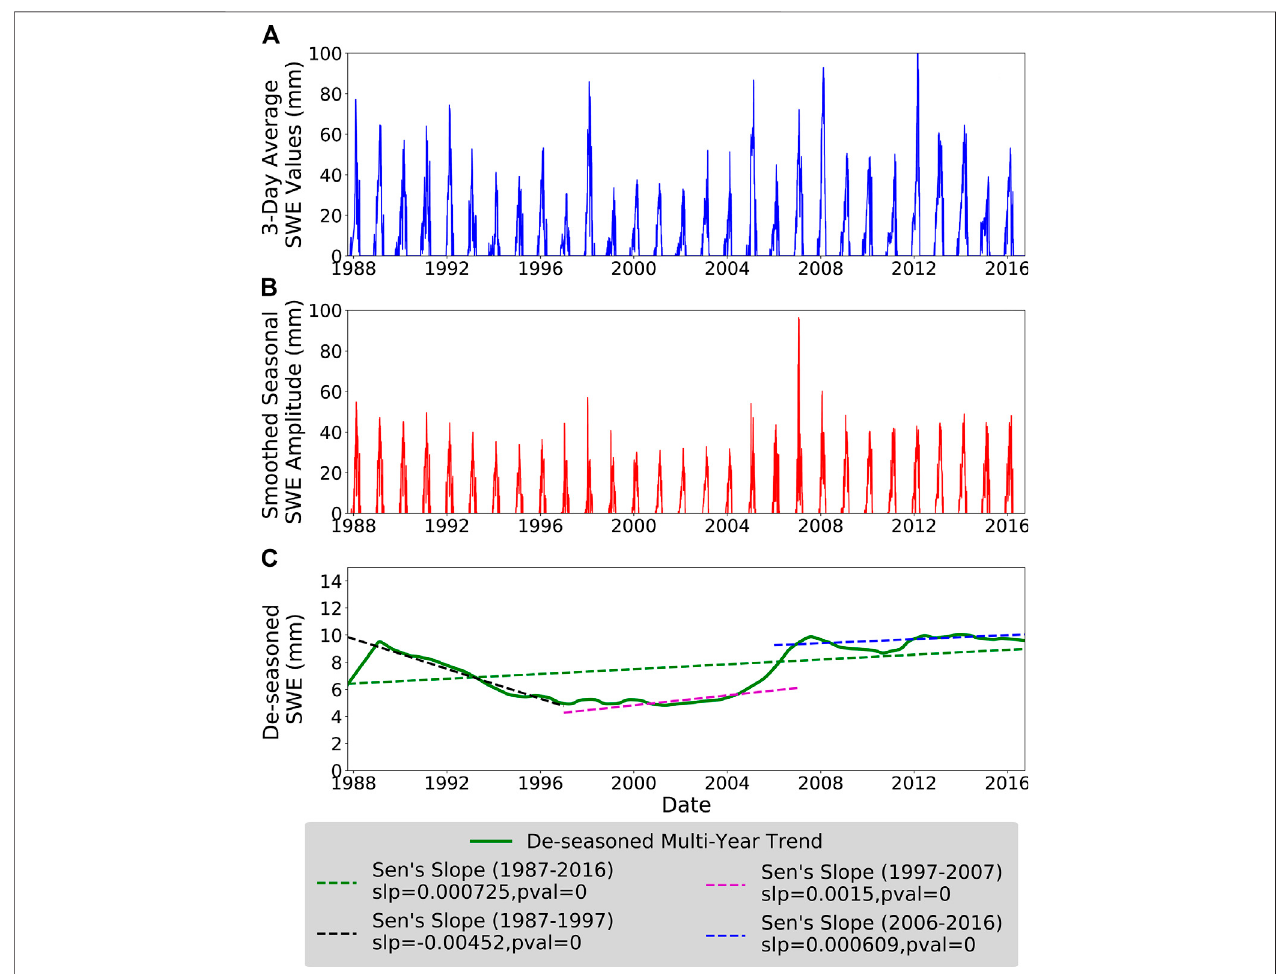
FIGURE2| Samplelocation(approx.72.06 ° E,38.64 ° N)illustratingthe (A) snow-waterequivalent(SWE)timeseries, (B) seasonalsignaltoberemoved,and (C) the long-term de-seasoned data. Dashed lines on (C) show fi tted lines using Sen ’ s slope estimator over the whole dataset (green), the fi rst decade (black), the second decade (purple), and the third decade (blue). There are strong oscillations in the fi tted SWE trend based on the start and end dates chosen.